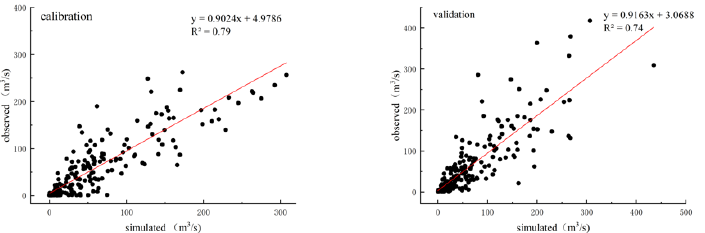
Figure 3. Scatter plots of the simulated and observed values during the calibration and validation.